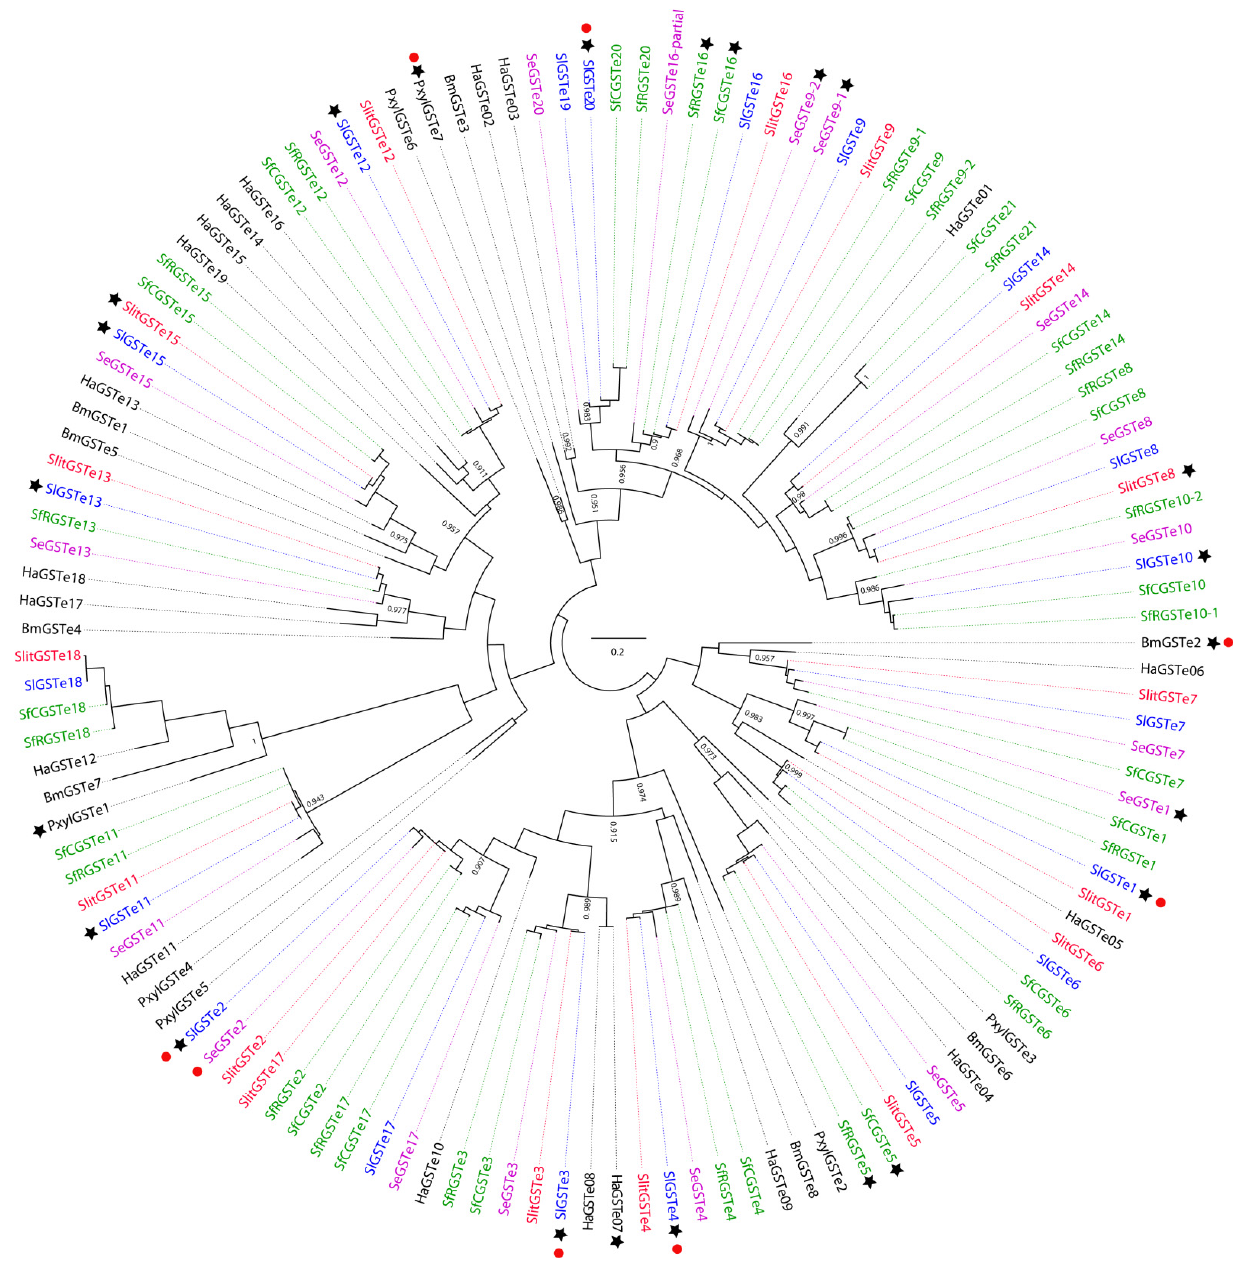
Figure 6. Maximum-likelihood phylogeny of lepidopteran epsilon glutathione-S-transferases (GSTes). The tree was built from amino-acid sequences of GST repertoires of S. littoralis (branches colored in red), S. frugiperda Corn and Rice strains (green), S. litura (blue), S. exigua (purple), H. armigera, P. xylostella and B. mori (black). Likelihood-ratio test values are only indicated in the internal nodes defining orthogroups, when aLRT > 0.9. Black stars indicate that GSTes are overexpressed in insecticide-resistant strains or when exposed to pesticides. Red dots indicate GSTes with demonstrated in vitro/in vivo insecticide resistance. The scale bar represents 0.2 expected amino-acid substitutions per site.